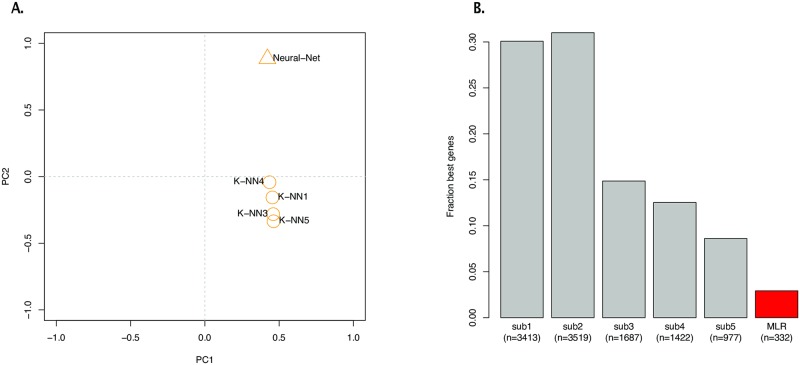
Gene inference challenge: Solutions clustering.(A): Plot showing results of the Principal Component Analysis (PCA) of the gene-level combined scores of all top five submissions for the CMap Inference Challenge. While all top submissions are clustered together in the first factor of PCA, they differ in the second factor, separating into different “clusters” the Neural Network approach (submission 2) and the other KNN based approaches (submissions 1, 3, 4, and 5). (B): Barplot showing the proportion (and count in parenthesis) of gene predictions used to form the ensemble, which uses the training dataset to select the best predicting algorithm from the MLR benchmark and the top 5 submissions (i.e., the algorithm achieving the highest combined score for a particular gene) for the CMap Inference Challenge.